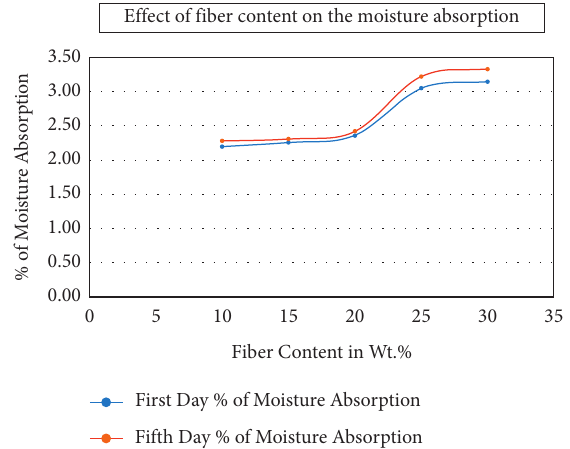
Figure 7: Water absorption of 100mm length of fiber composite with varying fiber concentrations.